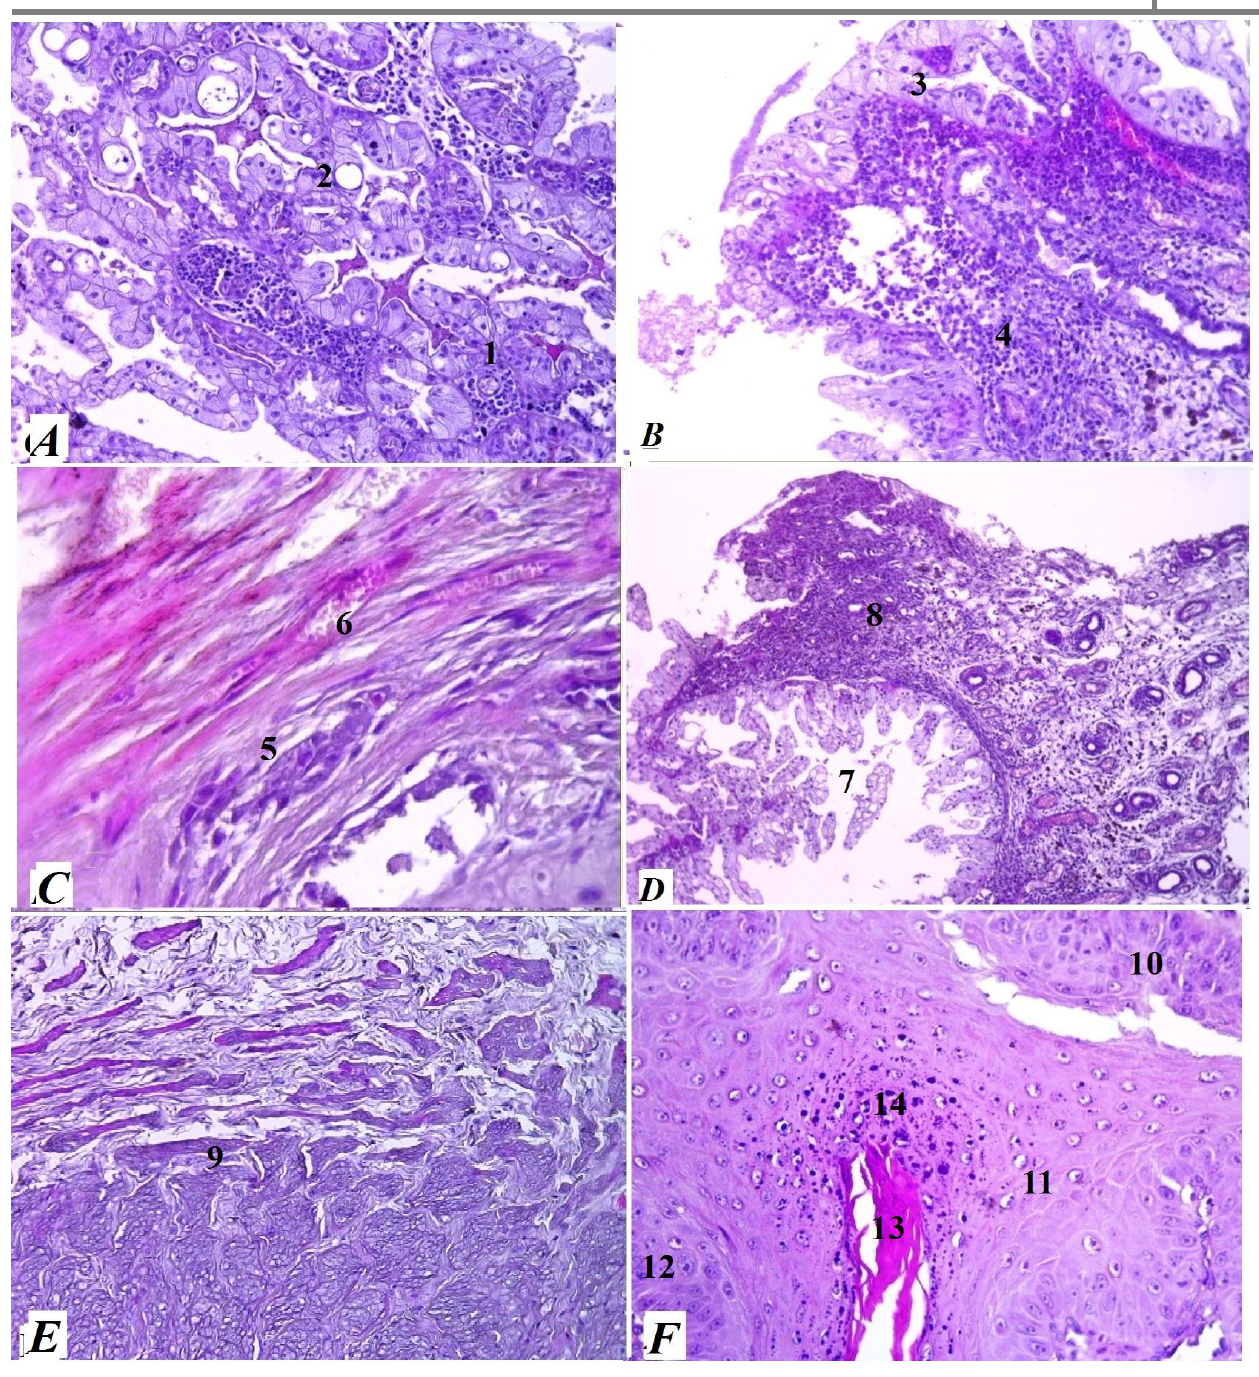
Figure 2. Histopathological cross sections of different types of tumours of various regions of the digestive system )H&E